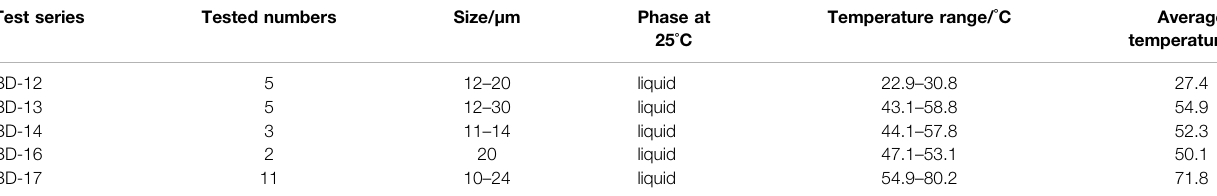
TABLE 2 | Homogenization temperatures of halite fl uid inclusions.